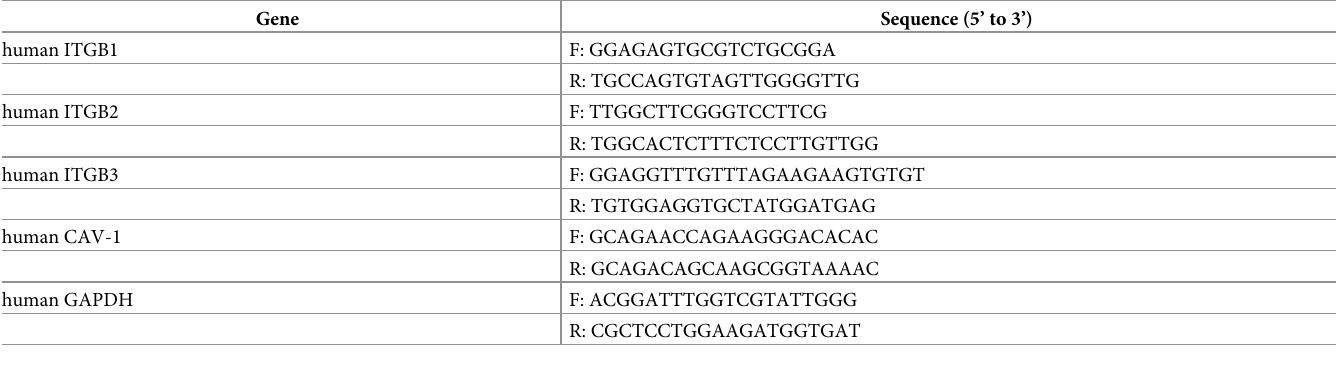
Table 1. Primers used in the real-time quantitative